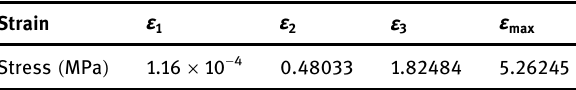
Table 7: Measured values of stress and strain Strain